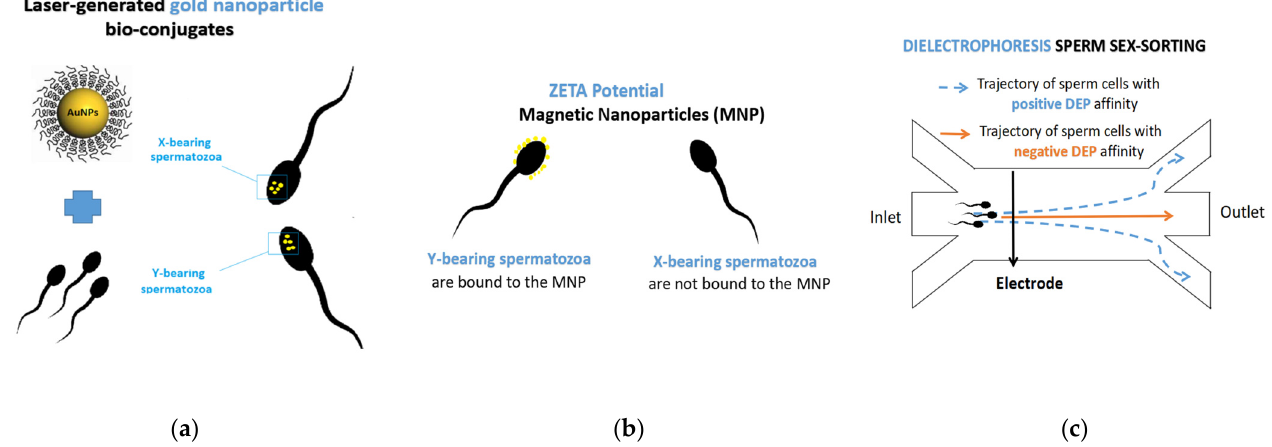
Figure 2. Schematic representation of emergent sex-sorting technologies: ( a ) laser-generated gold nanoparticles bio-conjugates, ( b ) Zeta potential, and ( c ) dielectrophoresis sperm sex-sorting.